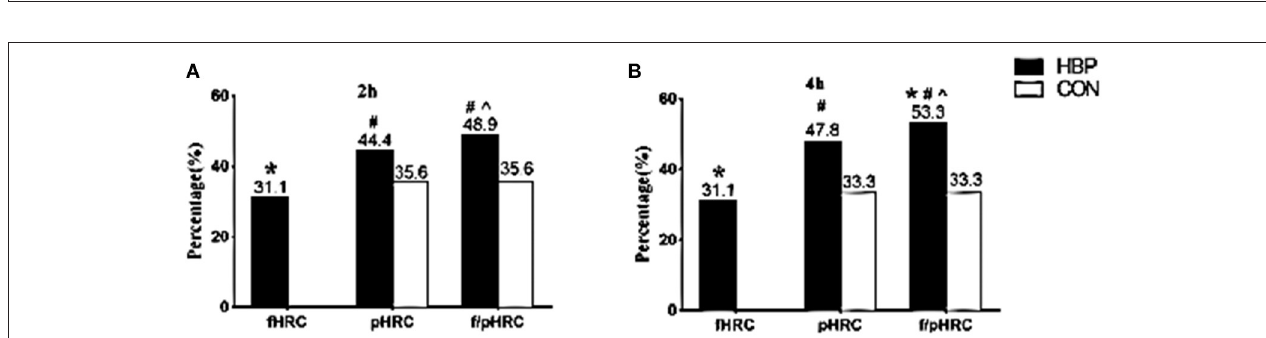
FIGURE 3 | Comparisons of the percentages of HRC between the two groups at different states. (A,B) Comparisons of the percentages of fasting HRC only (fasting RC ≥ 0.8 mmol/L, fHRC), postprandial HRC only (postprandial RC ≥ 0.9 mmol/L, pHRC), either fasting or postprandial HRC (fasting RC ≥ 0.8 mmol/L or postprandial RC ≥ 0.9 mmol/L, f/pHRC) at 2 or 4h after a daily breakfast. * P < 0.05 when compared with CON group. # P < 0.05 when compared with the percentage at fasting state in the HBP group. ∧ P < 0.05 when compared with the percentage of pHRC in the HBP group.